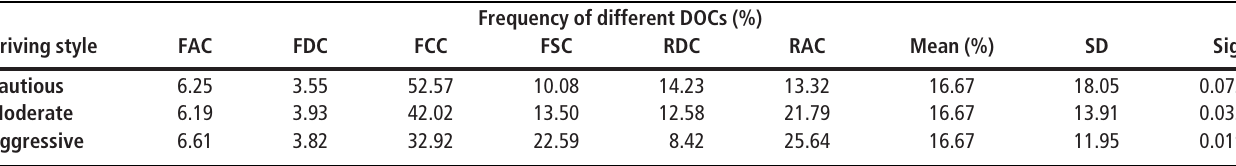
Table 12 Statistical analysis of frequency of different longitudinal DOCs